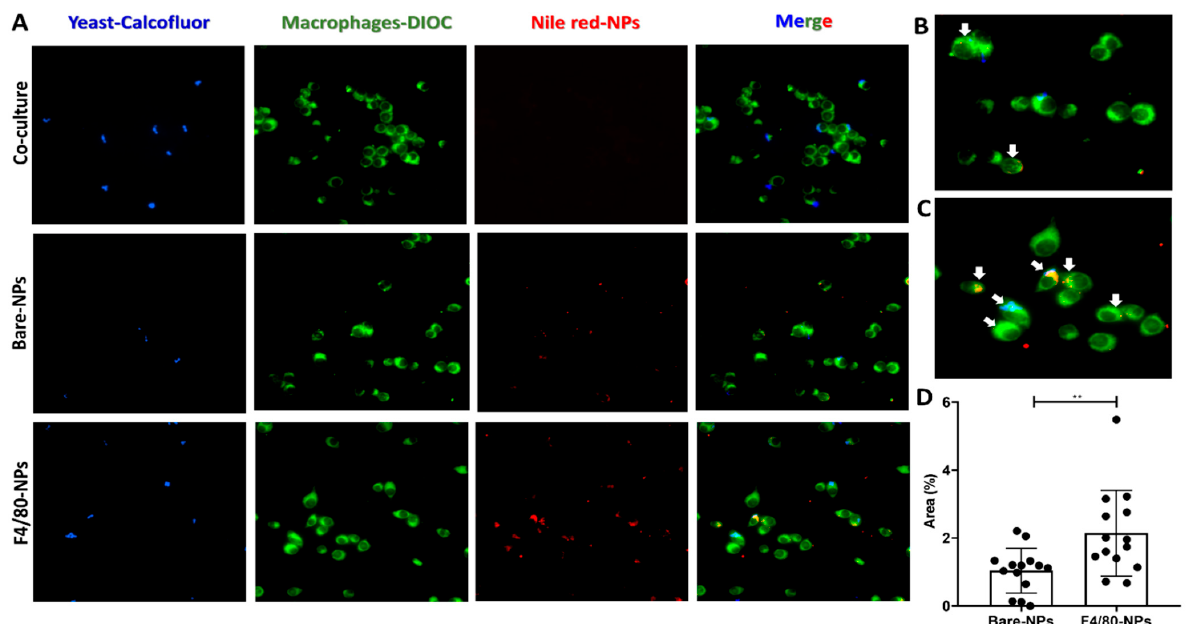
Figure 5. Endocytosis evaluation by fluorescence microscopy of anti-F4/80 antibody-functionalized PLGA75:25-TPGS-pH5-NPs encapsulating Nile red into J774A.1 macrophage H. capsulatum co-culture. ( A ) Images corresponding to the co-culture without NPs, bare-NPs, and F4/80-coated-NPs upon 6 h of incubation. Images from left to right were taken with DAPI filter (yeast-calcofluor stain), DIOC filter (macrophages-DIOC stain), TRITC filter (Nile red-encapsulated NPs), and merged (right), respectively. The scale is 20 µm. The zoomed-in ( B ) bare-NPs merged image and ( C ) F4/80-coated-NPs merged image. White arrows indicate macrophages infected with H. capsulatum with endocytosed NPs. ( D ) Endocyted NPs estimated by measuring Nile red by fluorescence intensity as described in the materials and methods section. ** indicates statistically significant differences with p < 0.001.